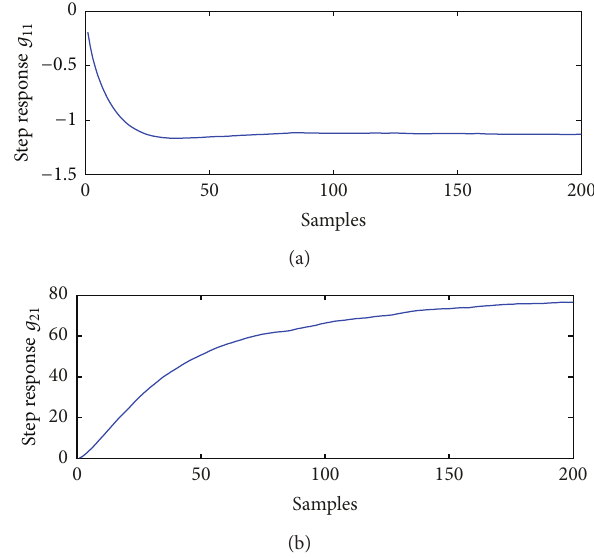
Figure8:Stepresponsecurveofbiodieselconcentrationandreactor temperature, respectively, under 𝐹 𝑜